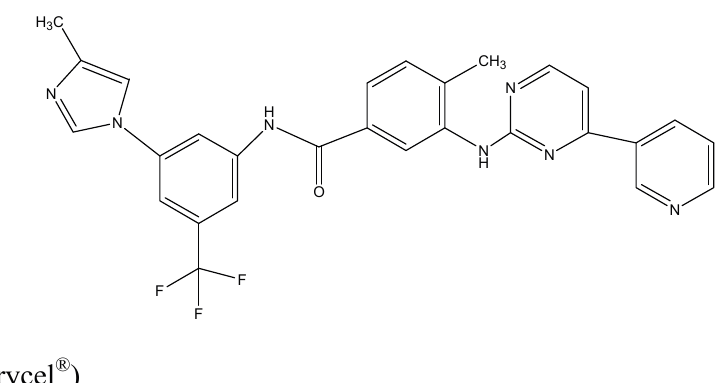
Figure 4. Structure of nilotinib.